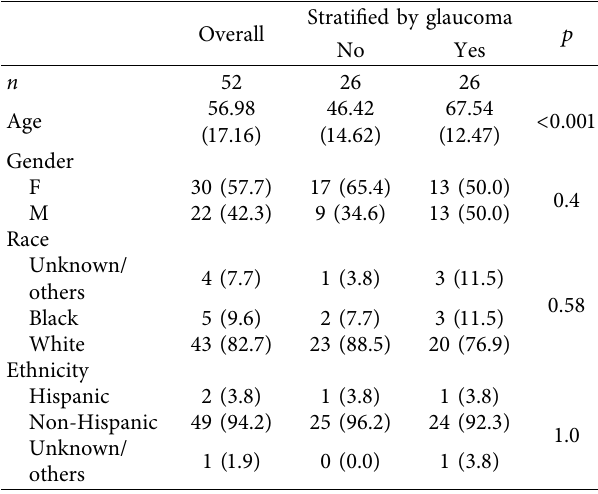
Table 1: Characteristics of our sample, both overall and stratified by whether the subject had glaucoma.